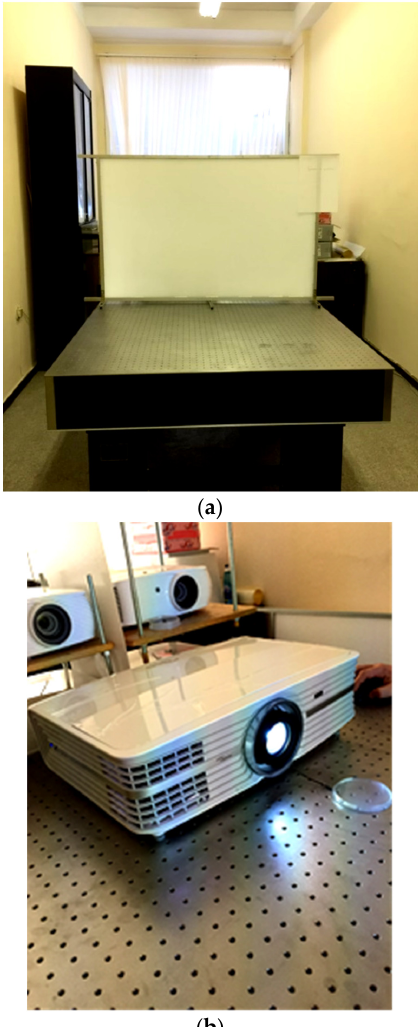
Figure 6. ( a ) Rear view of multi-projector 3D imaging system; ( b ) 4K projector in the front and four full HD projectors in the background.